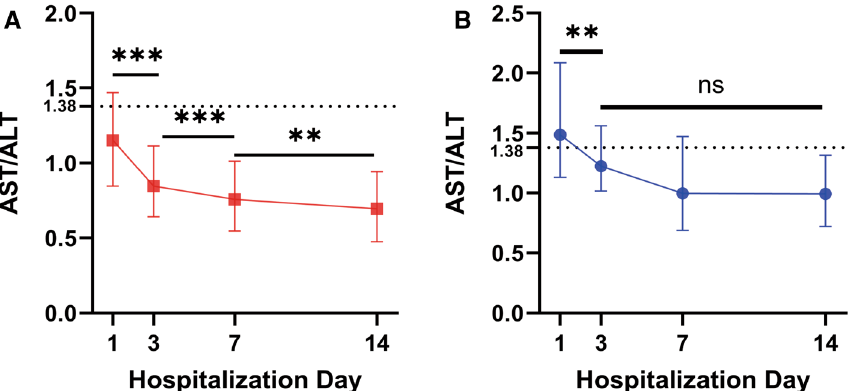
Figure 2. The dynamic changes in AST/ALT ratio in COVID-19 patients during hospitalization. Data were shown as the median (IQR). Paired Wilcoxon’s tests were used to compare two neighboring AST/ALT ratio. (A) The AST/ALT ratio of discharged patients who recovered from COVID-19. Data were available for 490 patients (day 1), 225 patients (day 3), 336 patients (day 7) and 279 patients (day 14). (B) The AST/ALT ratio of